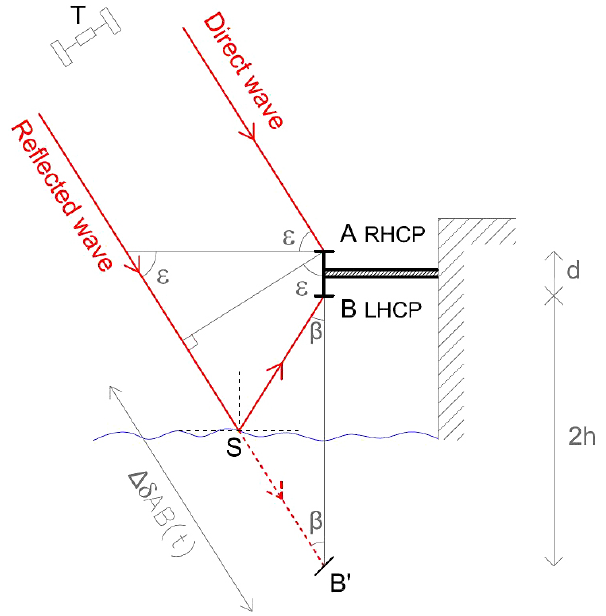
Figure 1. Principle of GNSS reflectometry. T : satellite/transmitter; S : specular reflection point; (cid:15) : satellite elevation; M δ AB (t) : addi- tional path covered by the reflected wave; d : interdistance between the LHCP and RHCP antennas; and h : height of the receiver above the reflecting surface.